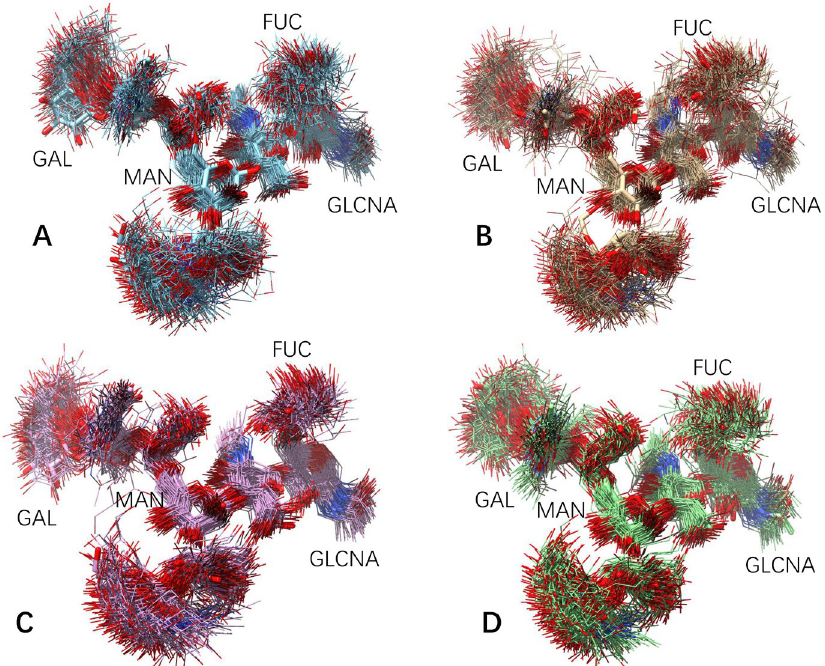
Figure 2. Fluctuation of glycan conformation in free antibody and in the antibody-antigen-hFcγRI complex. One hundred and fifty conformers are evenly selected from MD trajectories and superimposed. (A) and (B) Two carbohydrate chains in free antibody; (C) and (D) two carbohydrate chains in the antibody-antigen-hFcγRI complex. The G1F carbohydrate chain sequence is in Figure 1, and the key residues are labeled Table 1. RMSD (Å) of glycan conformations in different antibody binding states System Glycan Ave Sd Min Max Antibody Chain A Antibody-antigen Antibody- hFcγRI